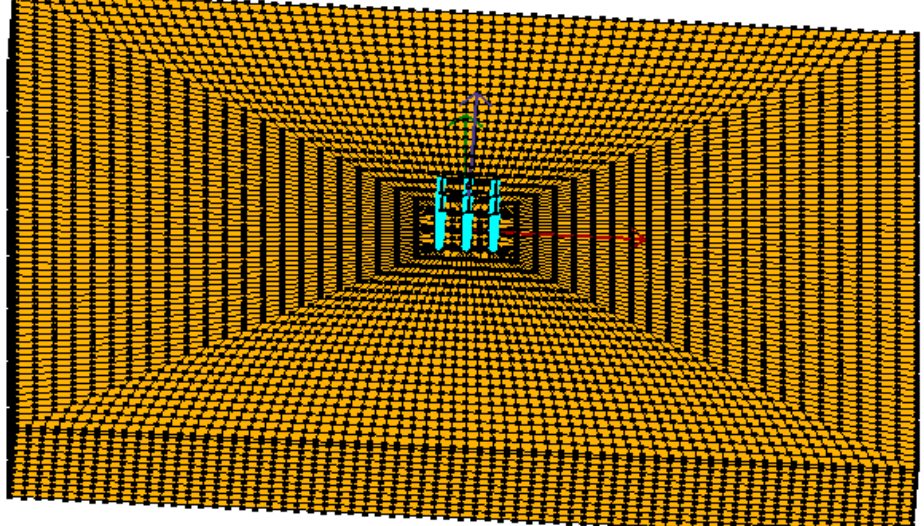
Figure 2. Three-dimensional (3D) mesh (Model 1).